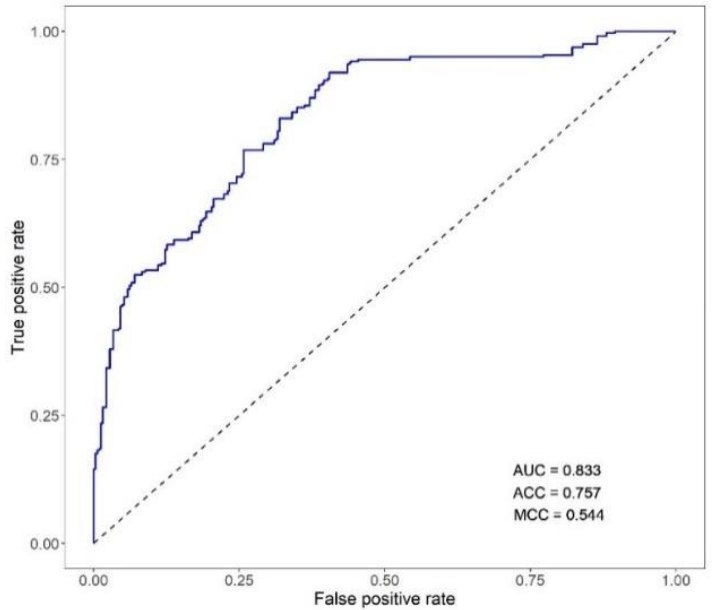
Figure 3. ROC curve for the classification of VNN mortality based on the estimated breeding values of the trait (EBV FULL : breeding value estimated using the animal phenotype and the phenotypes of its full- and half-sibs). AUC: area under the ROC curve; ACC: classification accuracy computed as (true positives + true negatives)/number of samples; MCC: Matthews correlation coefficient. Table 2. Average metrics (SD) of classification performance for different classifiers of VNN mortal- ity in 16 independent five-fold cross-validations.